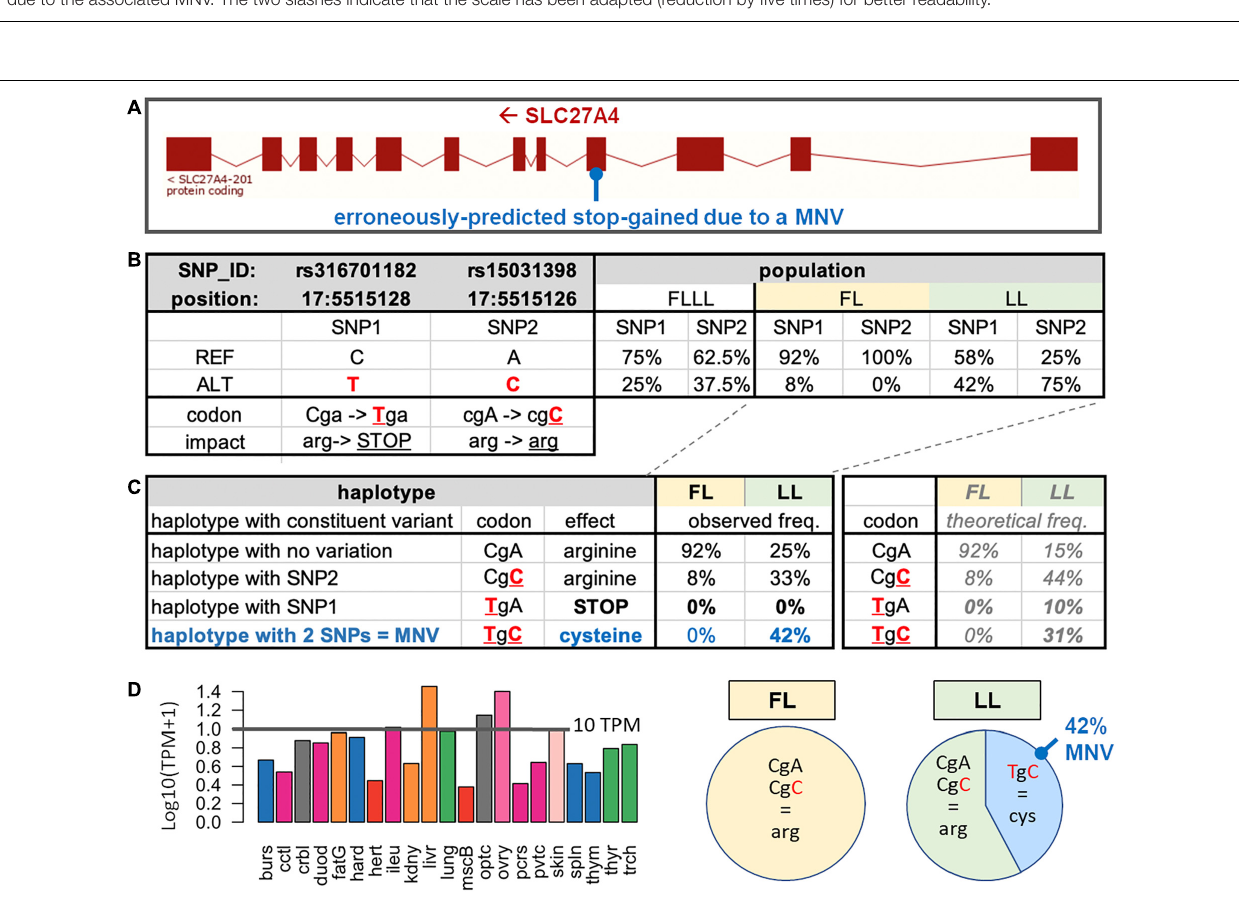
FIGURE 3 | Comparison of the functional impact of MNVs (right) and their component SNPs (left) for each of the 2,965 MNVs. Left: The consequence originally predicted for the component SNPs, the most severe impact being retained by the codon (see Figure 2 or the text for the order). Right: The new prediction associated with the MNVs. For each category of functional predictions of the component SNPs (left), the numbers and percentages are given with new predictions due to the associated MNV. The two slashes indicate that the scale has been adapted (reduction by five times) for better readability.